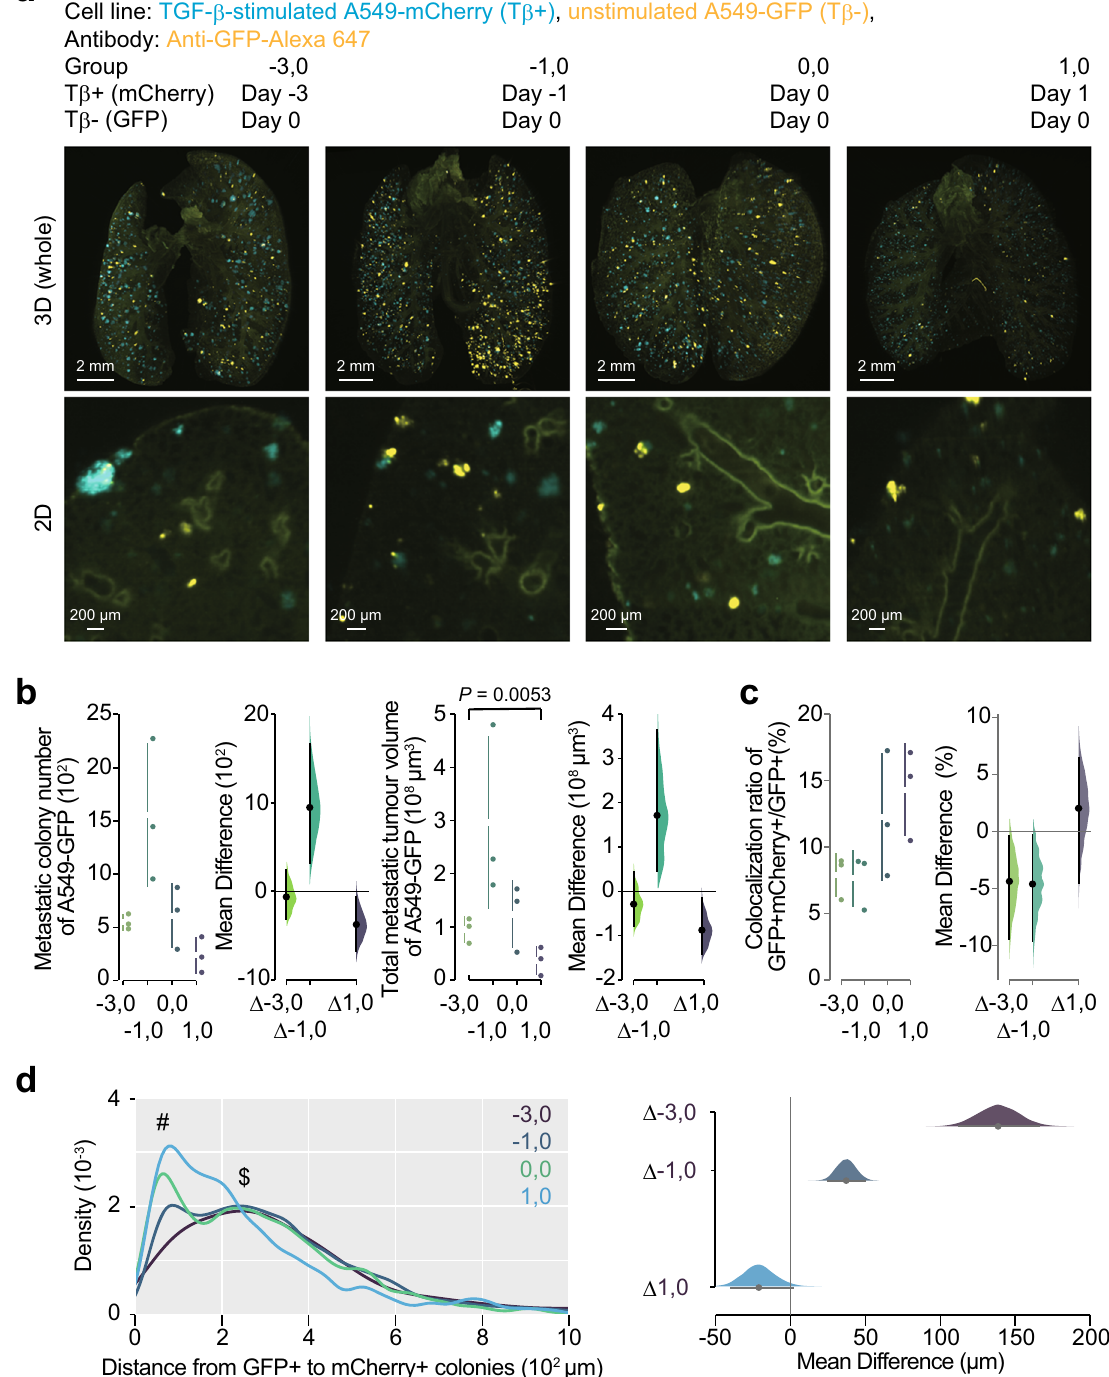
Fig. 4 TGF- β -stimulated cancer cells enhance colonization of unstimulated-cancer cells. Temporal analysis of the effect of TGF- β -stimulated cancer cells on the metastasis of unstimulated cancer cells. Unstimulated A549-GFP cells were intravenously injected in mice (day 0). Same number of TGF- β - stimulated A549-mCherry cells were intravenously injected in the same mice at the indicated time point. Then, the lung was subjected to whole-organ clearing protocol (day 14), followed by 3D imaging. a Representative images. b Quanti fi cation of the metastatic colony number and the metastatic tumour volume of A549-GFP cells in lungs of mice. c Quanti fi cation of the colonies in which unstimulated cells were co-localized with TGF- β -stimulated cells. The ratios of GFP-positive and mCherry-positive colony number to the total GFP-positive colony number were indicated. d Density plot of the minimal distance from GFP-positive colony to mCherry-positive colony is shown. # and $ indicate the peaks around 50 µ m and 250 µ m, respectively. 3D image (whole), scale bar = 2000 μ m. 2D image, scale bar = 200 μ m. Mouse number in each group is n = 3. Representative result of two independent experiments. Data represent the effect size as a bootstrap 95% con fi dence